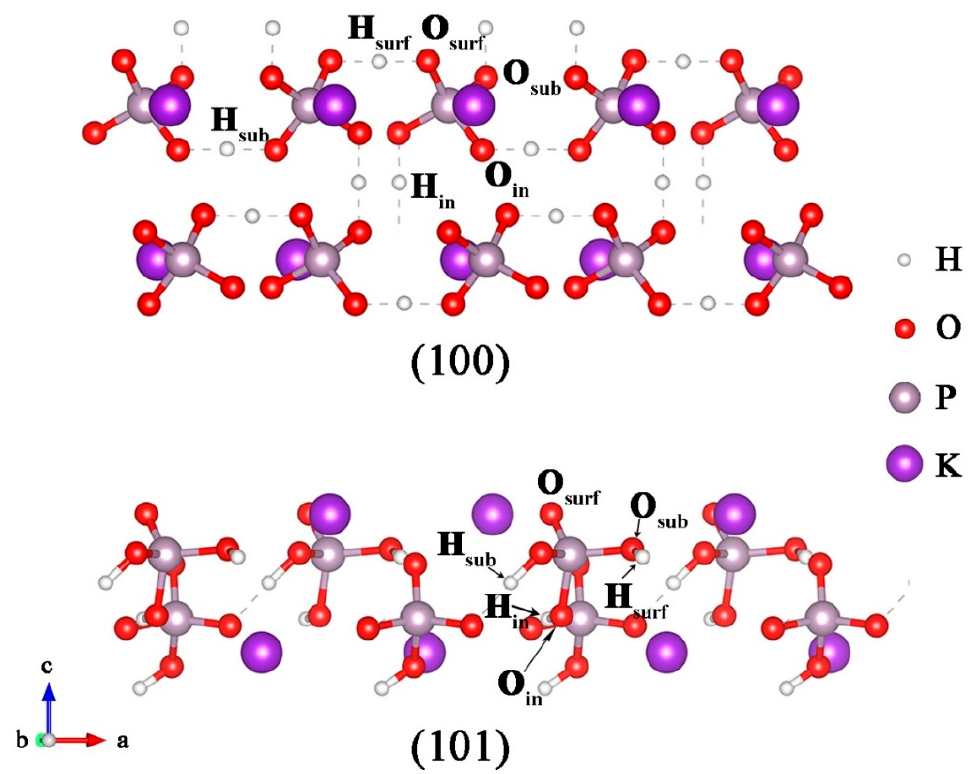
Figure 1. Structures of KDP (100) and (101) surfaces with two-molecule layers. The possible vacancy sites are labeled in the figures.